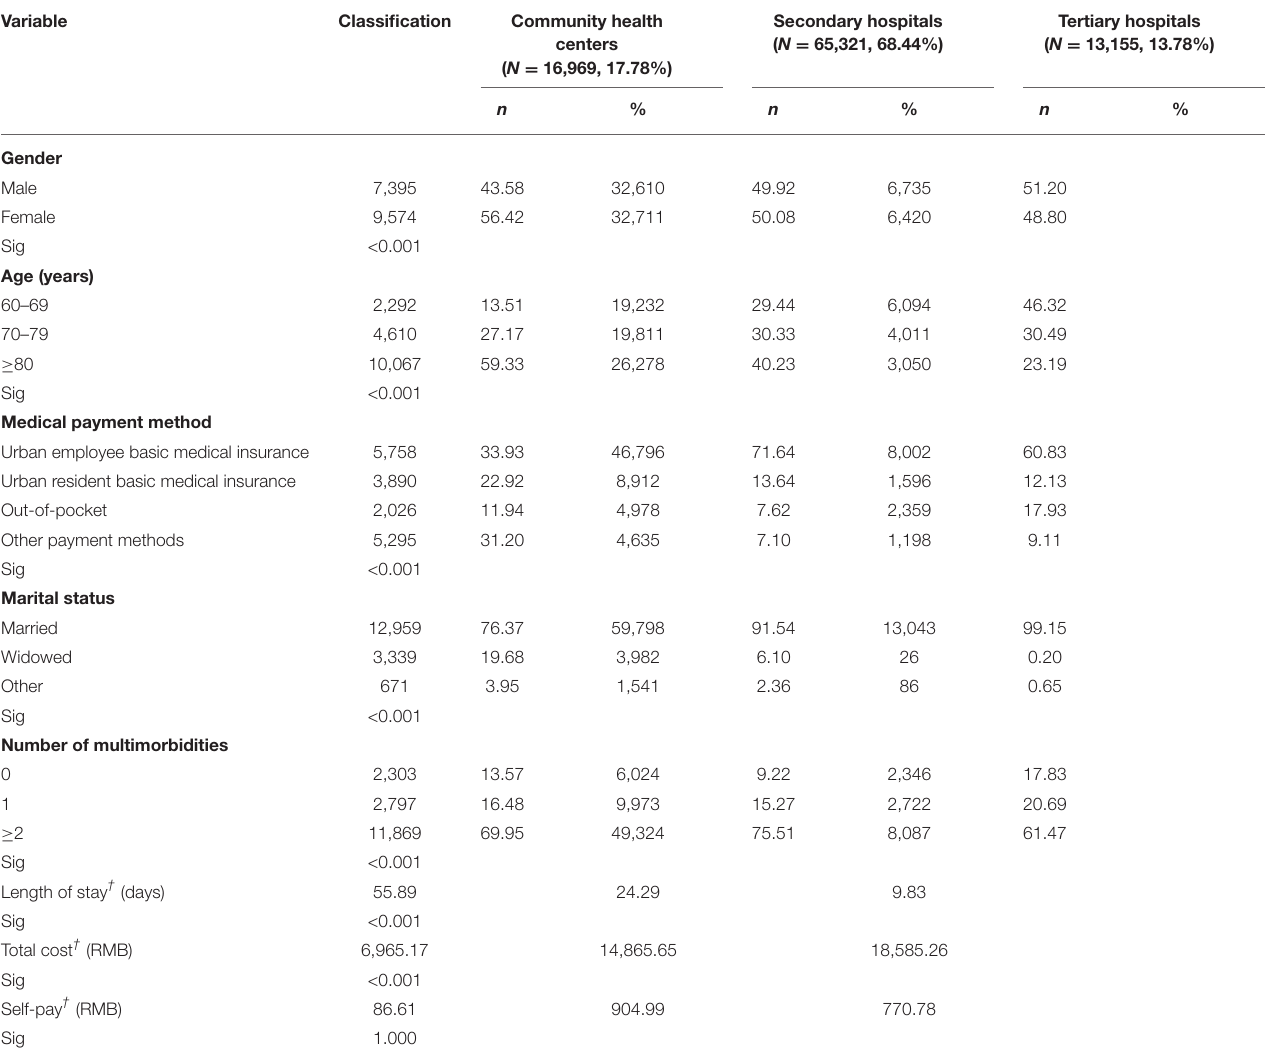
TABLE 1 | Demographic characteristics of elderly inpatients with chronic diseases in different institutions during 2013–2016 ( n =